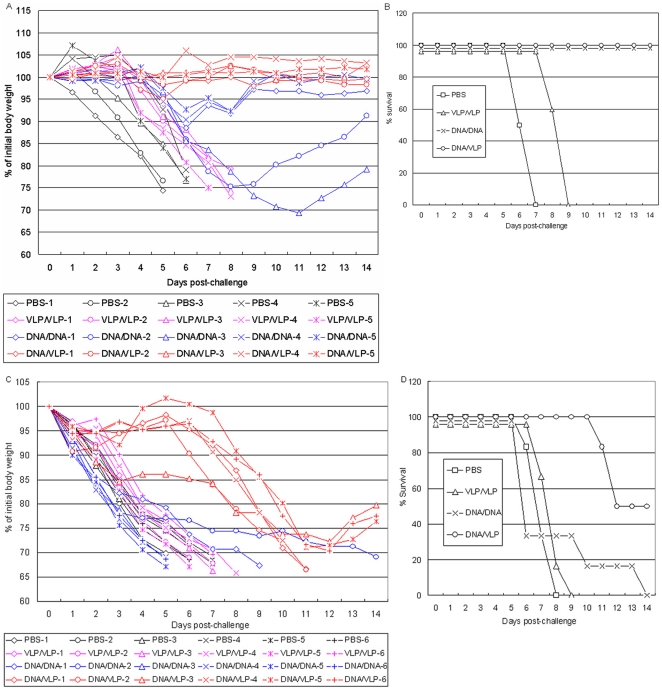
Comparison of vaccine efficacy elicited with heterologous DNA-VLP prime-boost versus homologous DNA-DNA, VLP-VLP prime-boost strategies in mice following 1000 MLD50 of homologous (A/Shenzhen/406H/06, clade 2.3.4) and heterologous (A/Cambodia/P0322095/05, clade 1) H5N1 virus challenge.A) Percentage of original body weight in individual mice after the 1,000 MLD50 of homologous H5N1 virus challenge. Black color: PBS control group; red color: heterologous DNA-VLP prime-boost group; pink color: homologous VLP-VLP prime-boost group; blue color: homologous DNA-DNA prime-boost group. B) Survival rates after the 1,000 MLD50 of homologous H5N1 virus challenge. Survival rate was calculated based on percent survival within each experimental group (n = 5 mice per experimental group). Open square: PBS control group; open triangle: homologous VLP-VLP prime-boost group; open circle: heterologous DNA-VLP prime-boost group; cross: homologous DNA-DNA prime-boost group. C) Percentage of original body weight in individual mice after challenged with 1000 MLD50 of heterologous (A/Cambodia/P0322095/05, clade 1) H5N1 virus. Black color: PBS control group; red color: heterologous DNA-VLP prime-boost group; pink color: homologous VLP-VLP prime-boost group; blue color: homologous DNA-DNA prime-boost group. D) Survival rates after challenged with 1000 MLD50 of heterologous (A/Cambodia/P0322095/05, clade 1) H5N1 virus. Survival rate was calculated based on percent survival within each experimental group (n = 6 mice per experimental group).